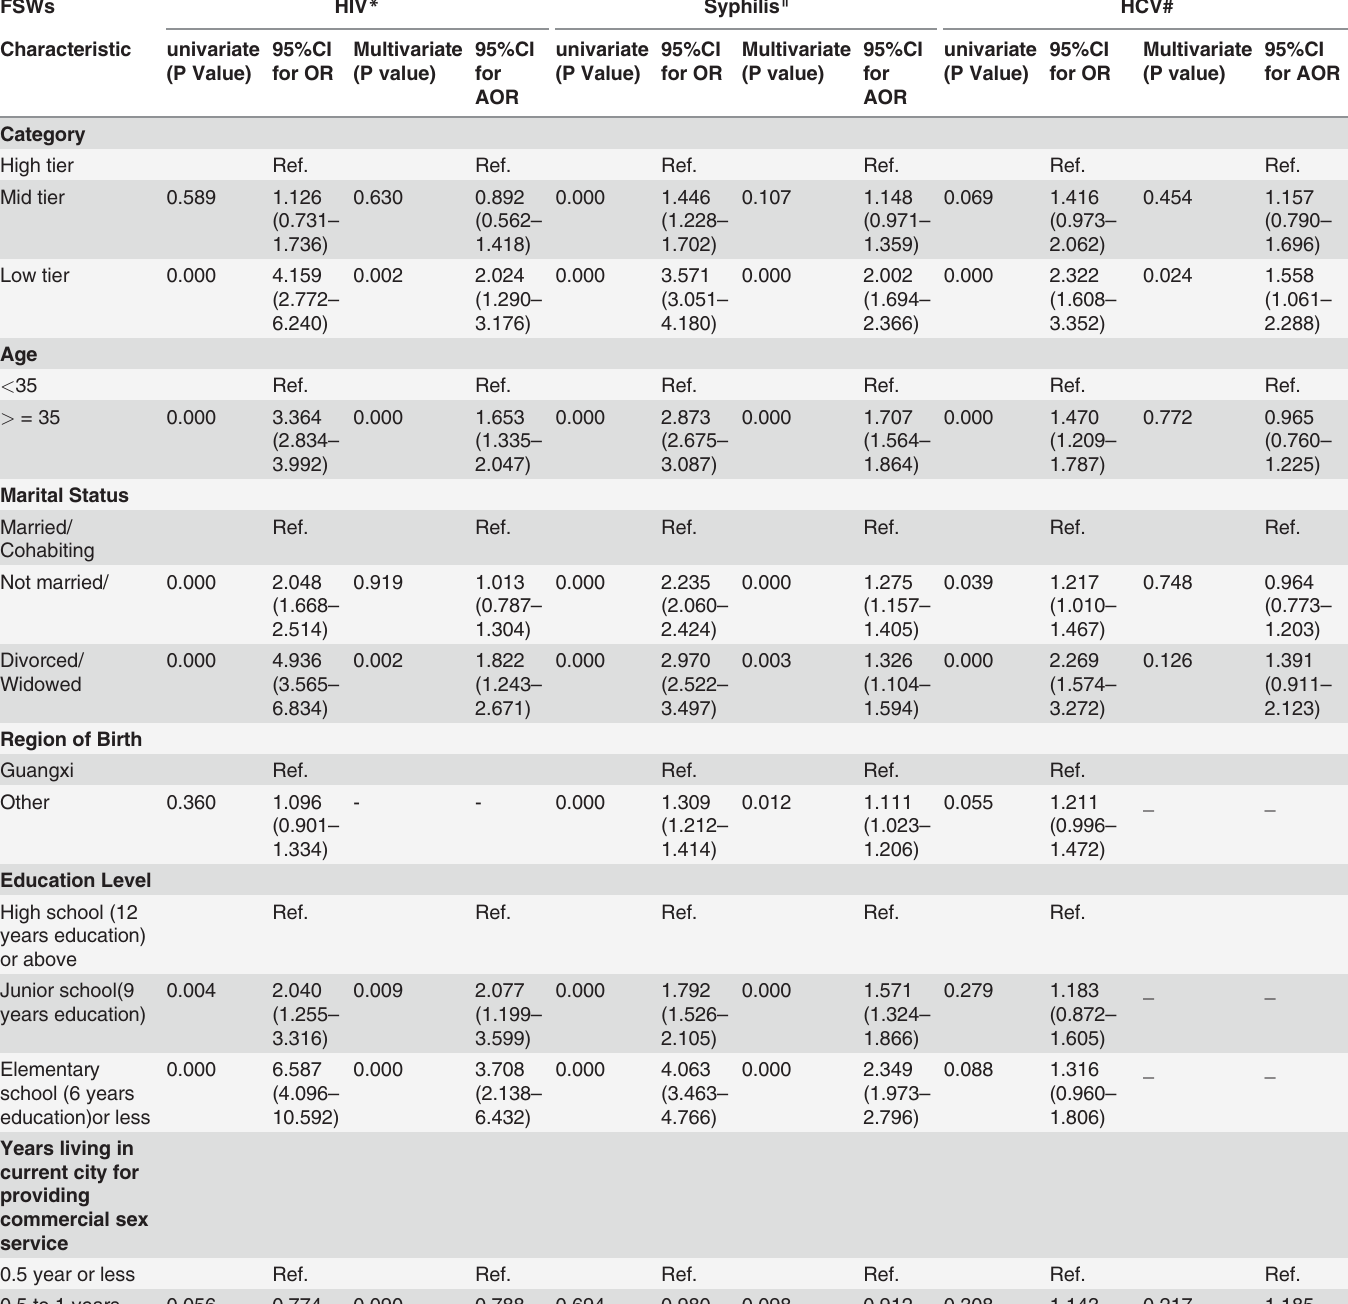
Table 4. Demographic and risk factors correlations of HIV or syphilis infection among female sex workers (FSW), Guangxi province, China, China National CDC HIV/AIDS Surveillance Data, 2010 – 2012. FSWs HIV *